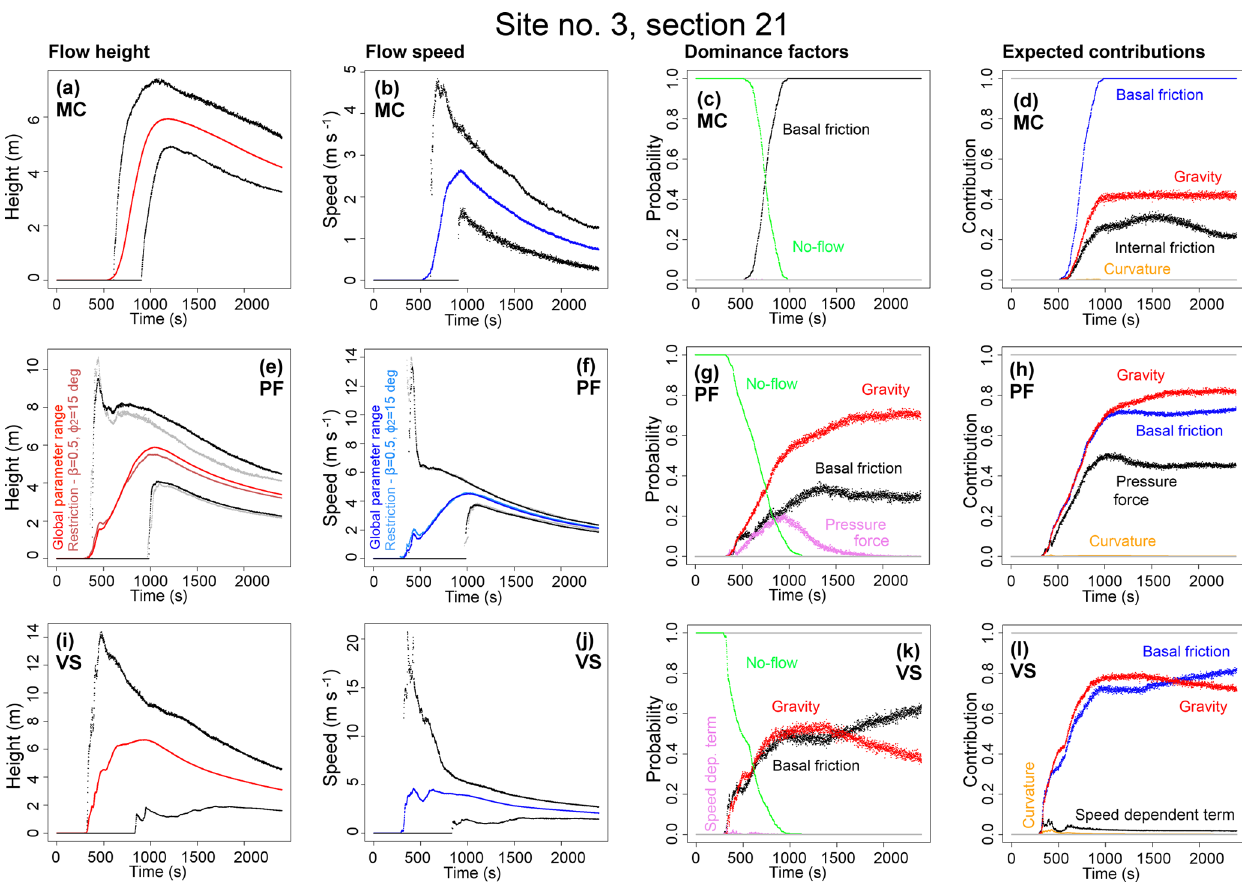
Figure 9. Local flow properties at Site 3, ∼ 2km upstream from Atenquique village. Panels (a, e, i) show flow height, (b, f, j) flow speed, (c, g, k) dominance factors, (d, h, l) and expected contributions of the force terms. Different models are plotted separately: (a–d) assume MC, (e–h) assume PF, and (e, f) include estimates on a hyperplanar restriction of the input domain; (i–l) assume VS. In (a, b, e, f, i, j) , the colored line is the mean value, and black and gray lines are the 5th and 95th percentile